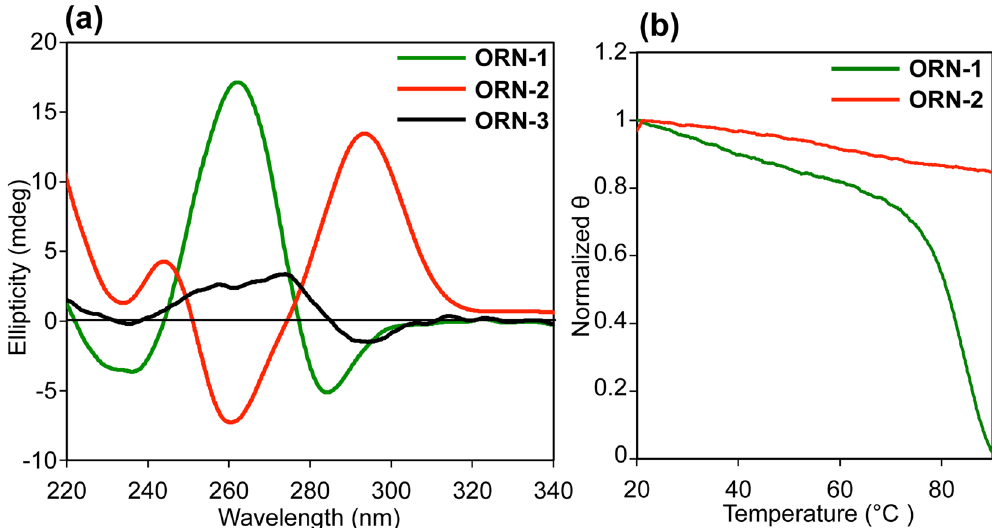
Figure 1. ( a ) CD spectra of ORN-1, ORN-2 and ORN-3 in the presence of 100 mM KCl at 25 °C. ( b ) CD melting curves for ORN-1 and ORN-2 monitored at 265 and 295 nm,